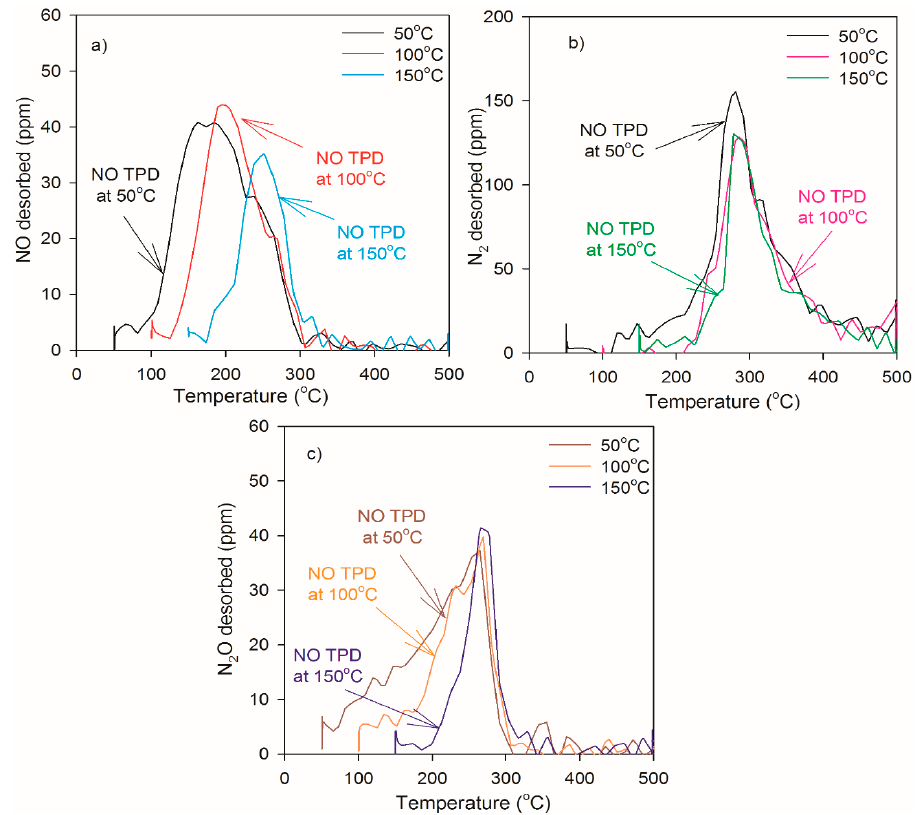
Figure 1. ( a ) . NO concentration and temperature as function of the time, ( b ) resulting N 2 , NO 2 , and N 2 O concentrations, ( c ) corresponding heat flow during NO TPD at 100 °C for 2 wt. % Pt/Al 2 O 3 . Experimental details are described in Section 3.